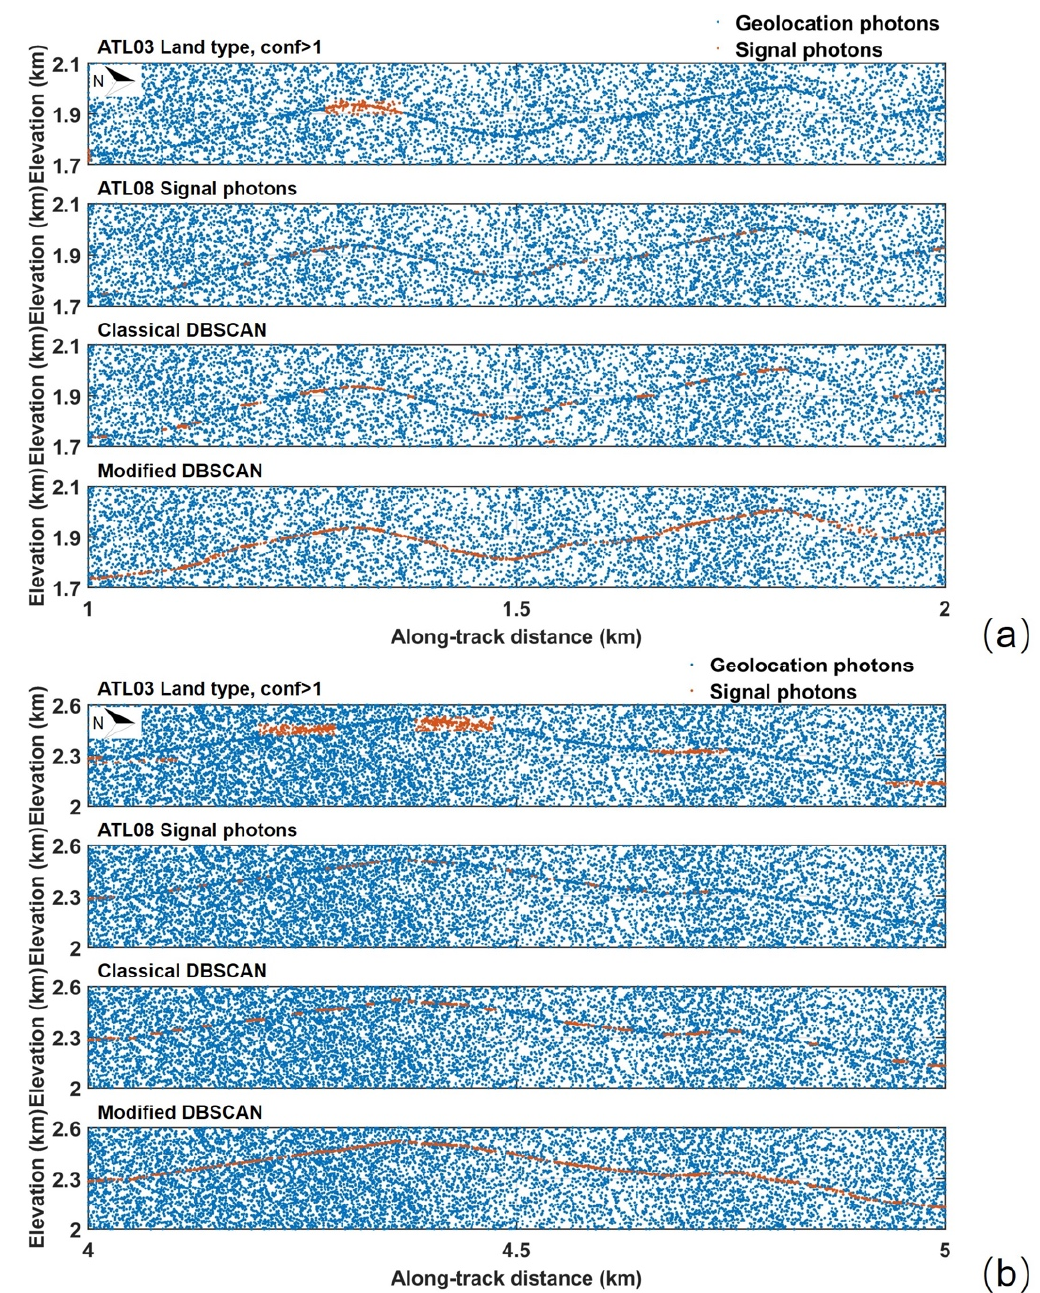
Figure A6. Detailed comparison of the results from the different signal photon extraction methods in the fourth study area. ( a ) Enlarged along-track segment corresponding to the yellow box in Figure A5a at the along-track distance from 1 km to 2 km. ( b ) Enlarged along-track segment corresponding to the green box in Figure A5a at the along-track distance from 4 km to 5 km.